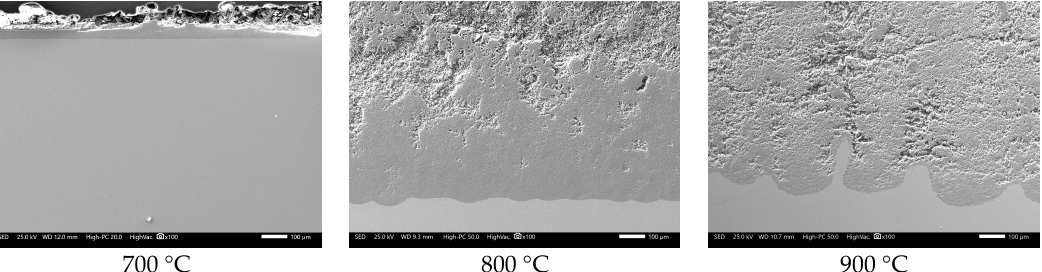
Figure 2. Cross-section aspect of 304H steel after corrosion test for 100 h in NaVO 3 .